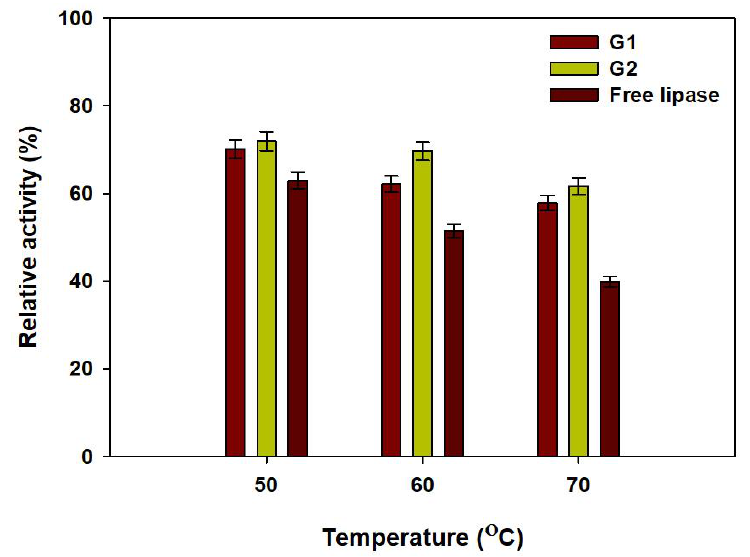
Figure 7. Thermal stability of free and immobilized lipase stored at 50, 60, and 70 °C for 3 h. A 100% relative activity corresponds to the results obtained at 30 °C. All data are presented as the means ± standard deviation of three experiments.